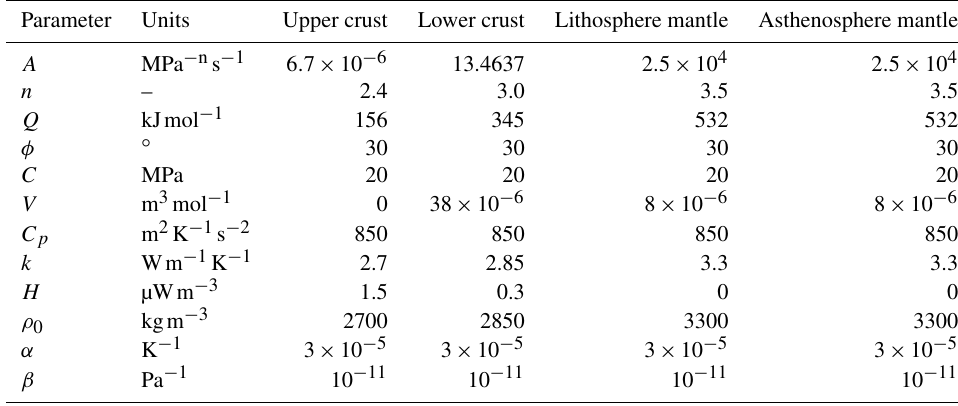
Table 1. Physical parameters for the thermo-mechanical rift model. Parameter Units Upper crust Lower